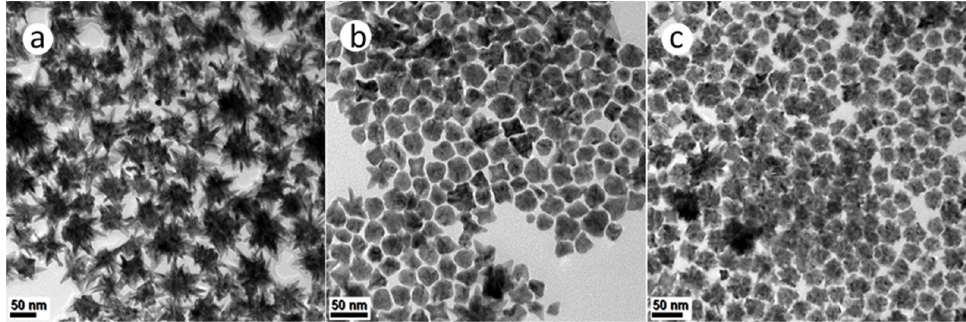
Figure 4. TEM BF images of PtNi, PtCo and Pt(NiCo) alloy NPs solution-grown via thermolytic decomposition of Pt(acac) 2 in the presence of ( a ) Ni(Ac) 2 , ( b ) Co(Ac) 2 and ( c ) Ni(Ac) 2 + Co(Ac) 2 in dual amine surfactants OAm and HDA.